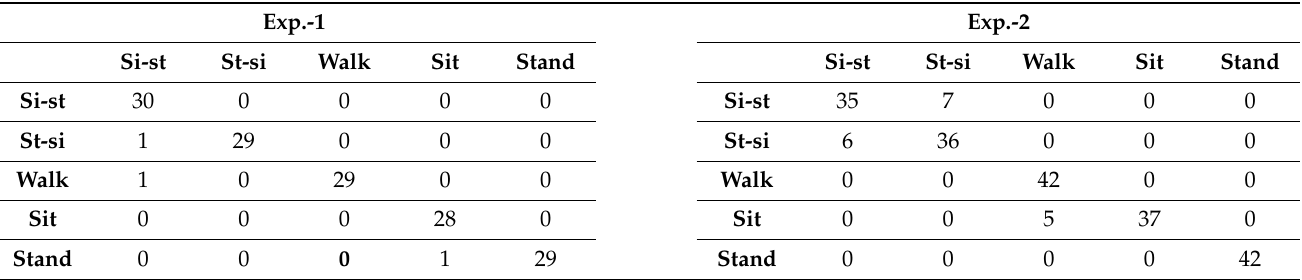
Table 12. Calculated confusion matrix for experiment-1 (left) and experiment-2 (right) when time domain features are